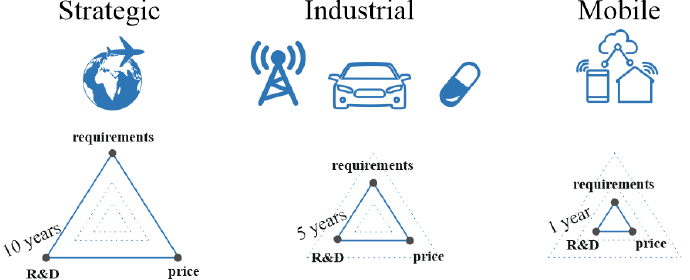
Fig. 3. MEMS device